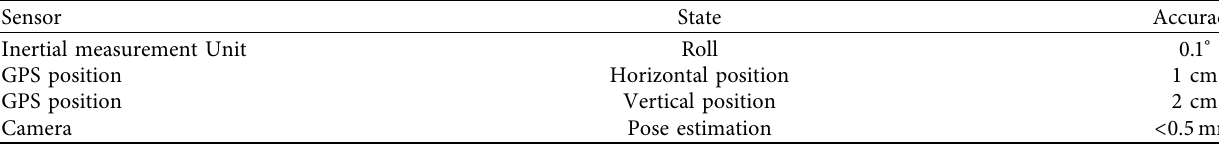
Table 2: Different sensor accuracy performance comparison.